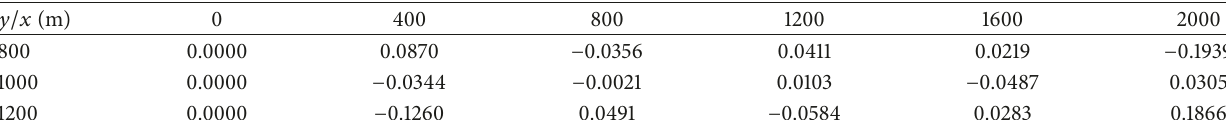
Table 3: Approximated water flow velocity in 𝑥 -direction 𝑢(𝑥,𝑦,𝑡) (m/s).